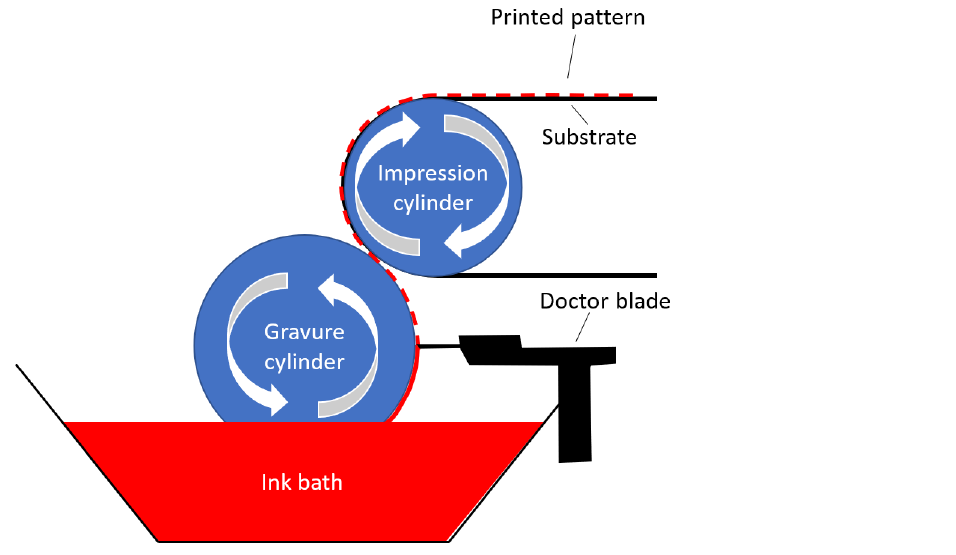
Figure 12. Schematics of gravure